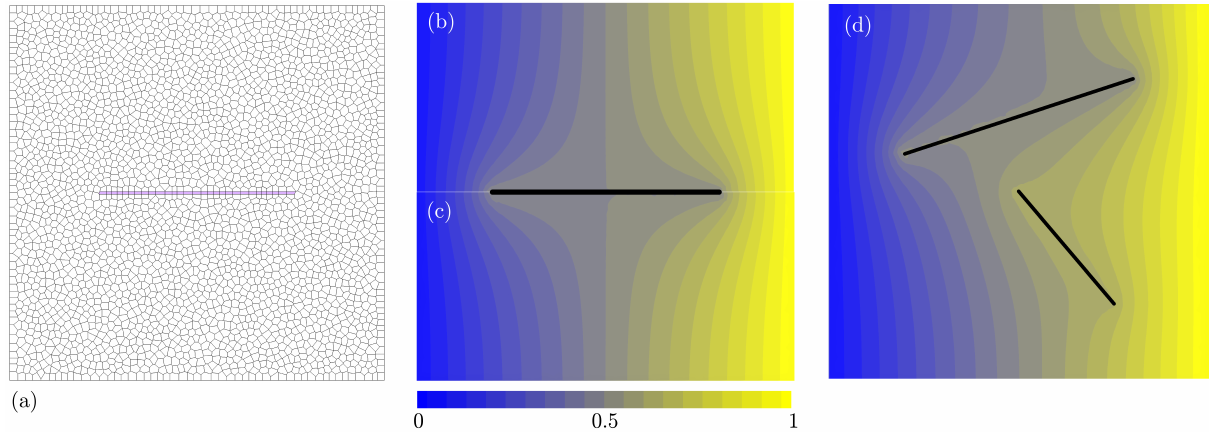
Figure 4. Planar lattice modeling of fiber inclusions: ( a ) discrete representation of a single fiber aligned with the direc- tion of flow; ( b ) corresponding potential distribution; ( c ) potential distribution based on semi-discrete fiber approach; and ( d ) application of semi-discrete approach to multiple